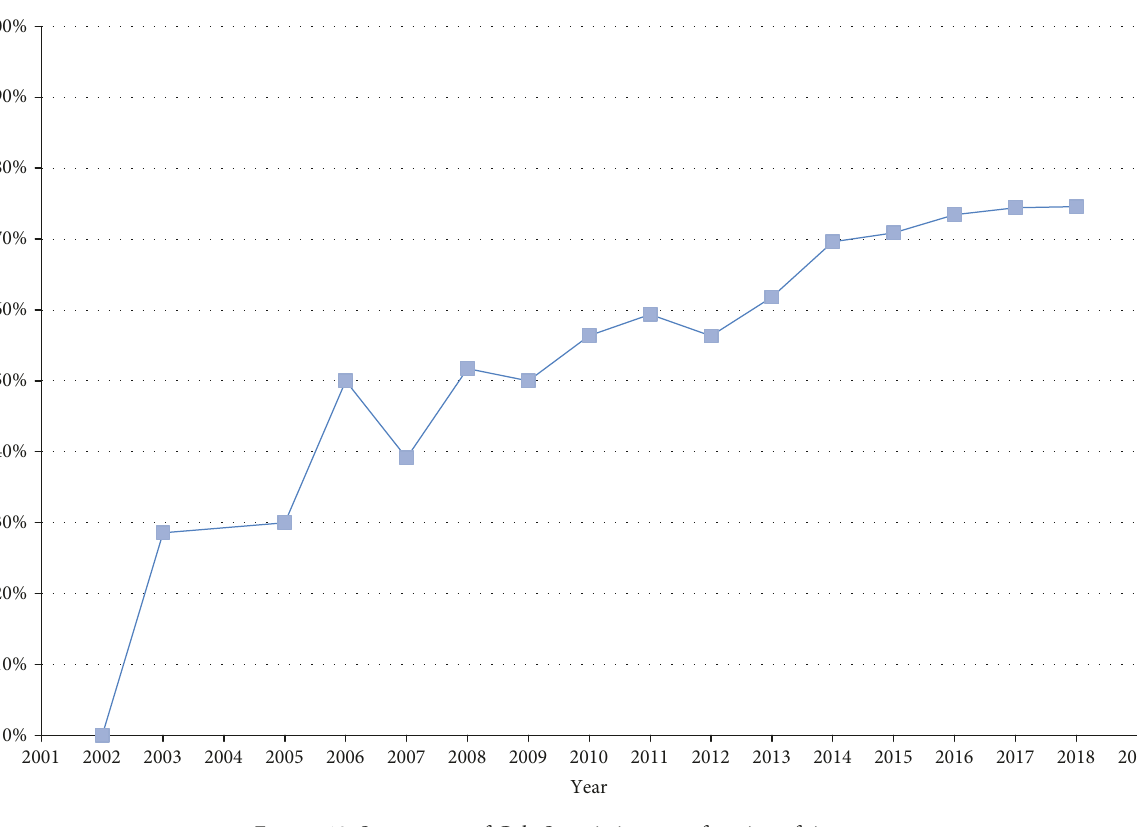
Figure 10: Success rate of CubeSat missions as a function of